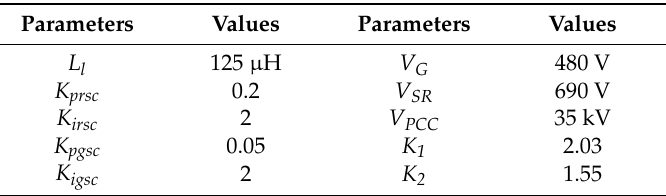
Table A2. 5 MW DFIG L filter and controller